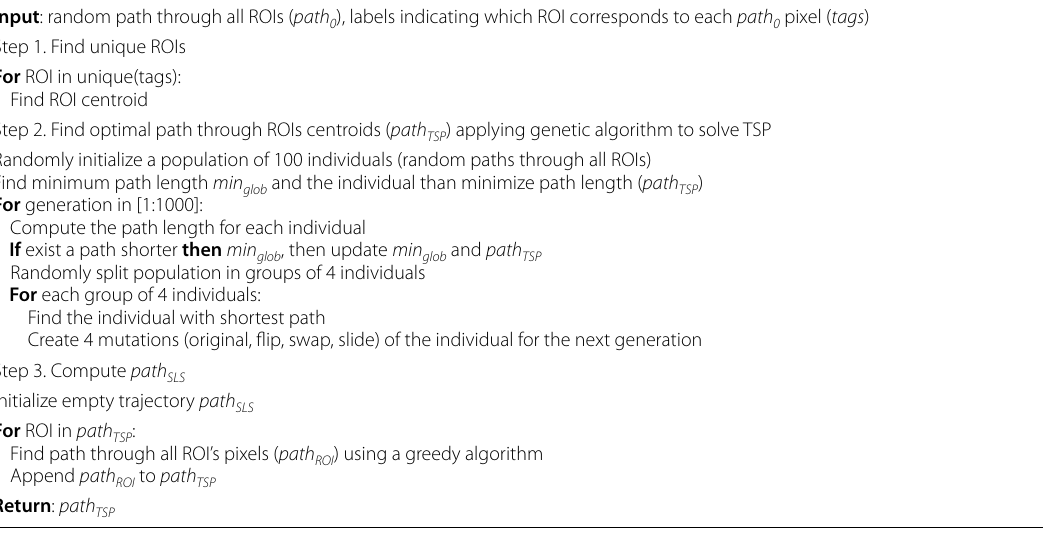
Table 1 Pseudocode for SLS trajectories optimization and